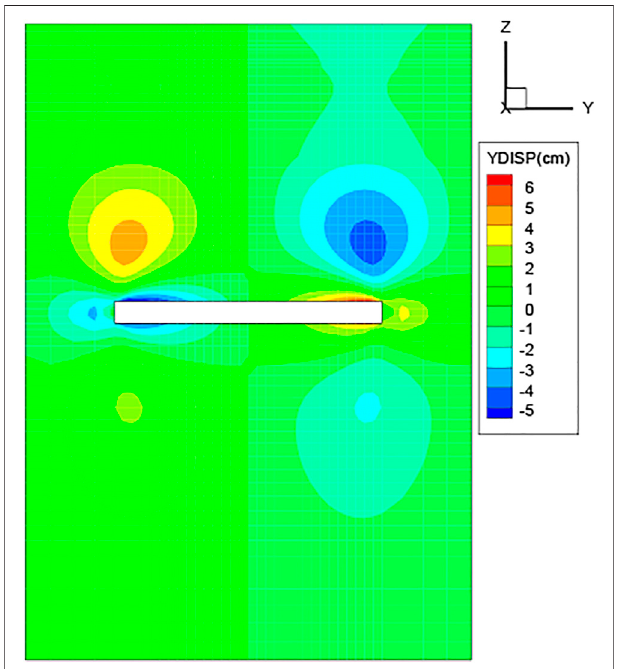
FIGURE 11 | Horizontal displacement curves of the roof at different heights above the ore rooms.